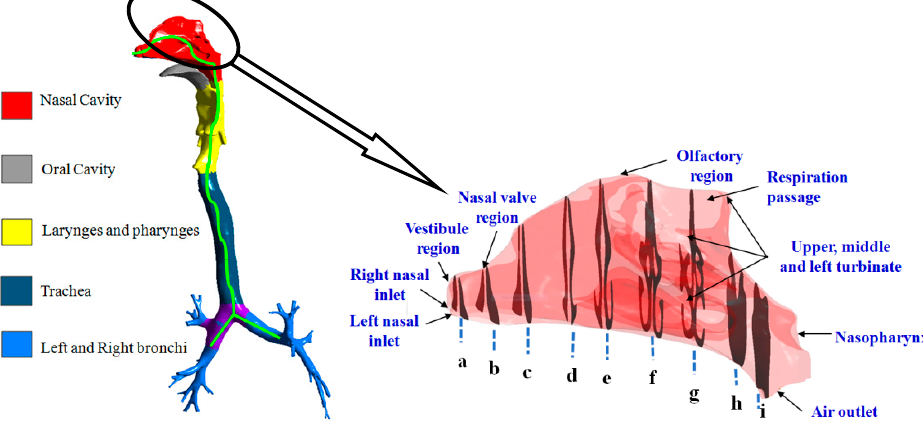
Figure 1. Reconstructed model of the human airway showing the translocatory pathway of RSPM.